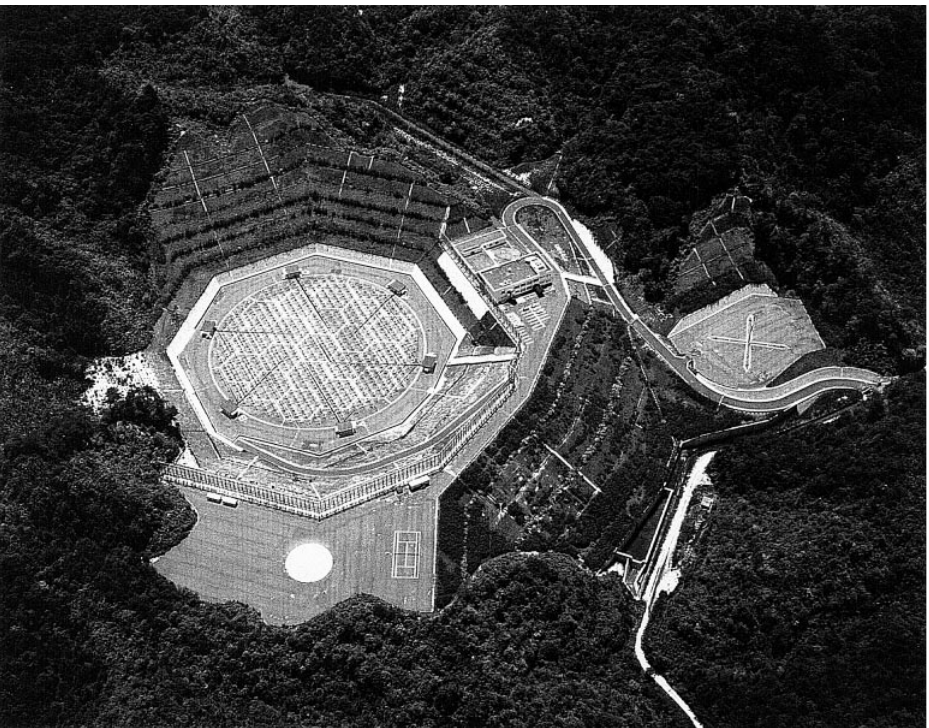
Fig. 6. An aerial view of the MU radar near